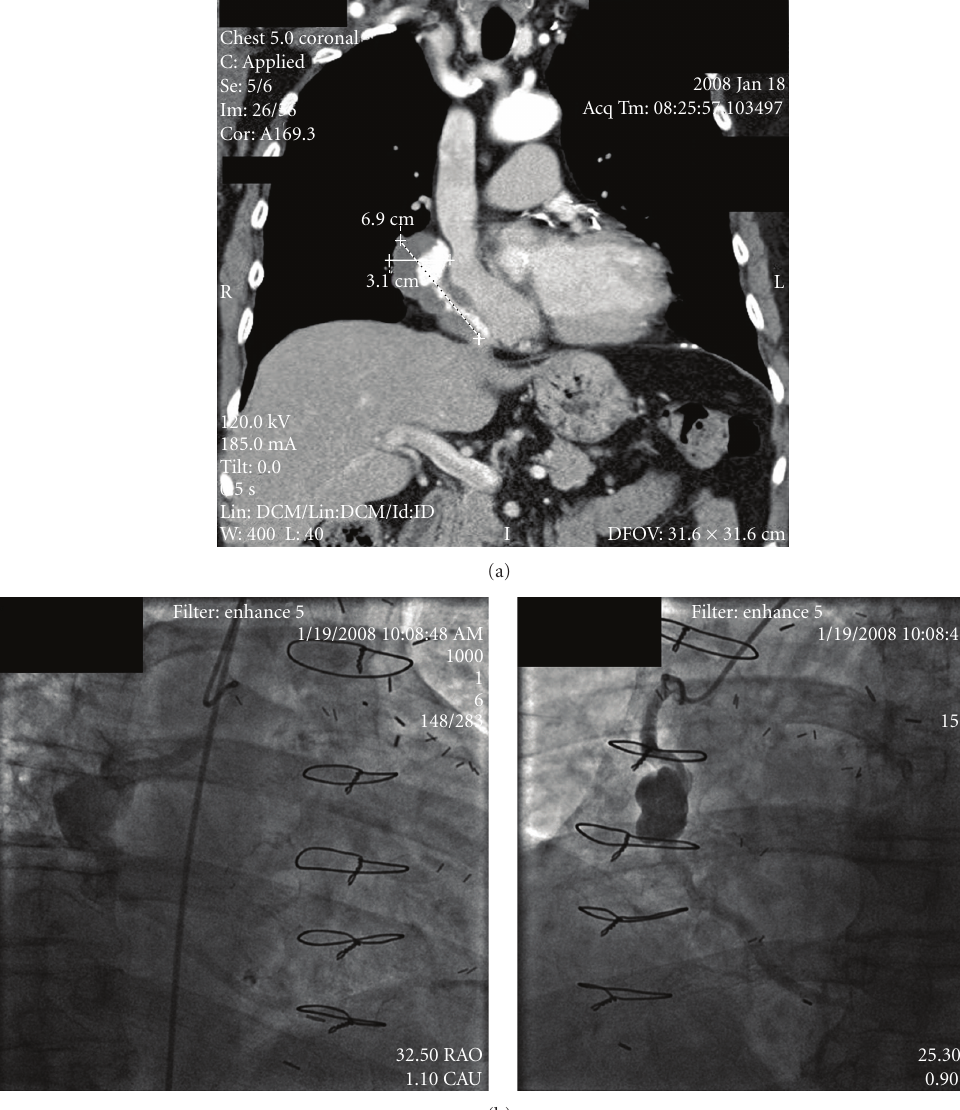
Figure 2: (a) Computer tomography (CT) in January 2008 of chest revealing a 3.1 cm × 6.9 cm aneurysm with contrast filling the inner lumen, and possible thrombus filling the remaining space within the aneurysm. (b) Coronary angiography depicting the aneurysm of the mid SVG, with TIMI 2 flow in right posterior descending artery (PDA) in both right anterior oblique (RAO) and left anterior oblique (LAO)